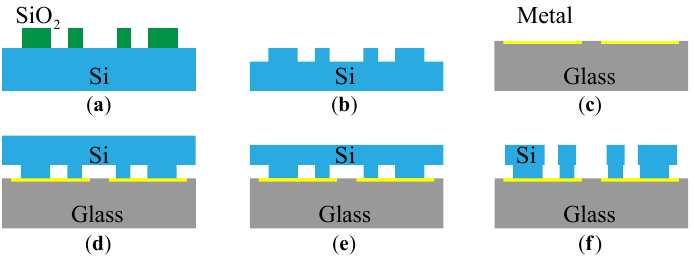
Figure 15. The procedure of the deep dry silicon on glass (DDSOG) technology. ( a ) Anchoring on the silicon wafer. ( b ) Etching the bonding area on the silicon wafer. ( c ) Depositing the metal conductive layer onto the glass substrate. ( d ) Bonding the silicon wafer to the glass substrate. ( e ) Thinning and polishing the silicon wafer. ( f ) Inductively coupled plasma (ICP) etching and structure releasing. The fabricated structure of the micro-gyroscope equipped with the two-stage elastic stopper